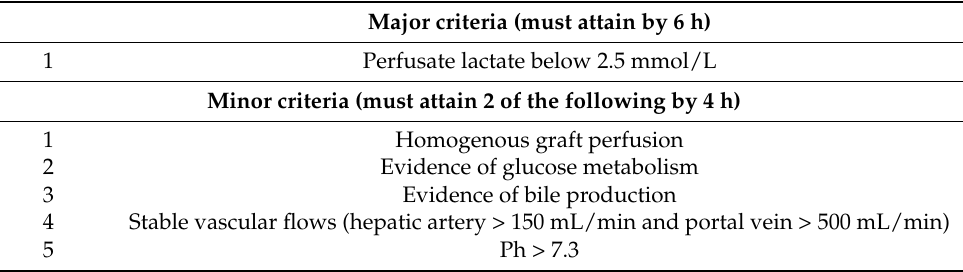
Table 1. Birmingham viability criteria.